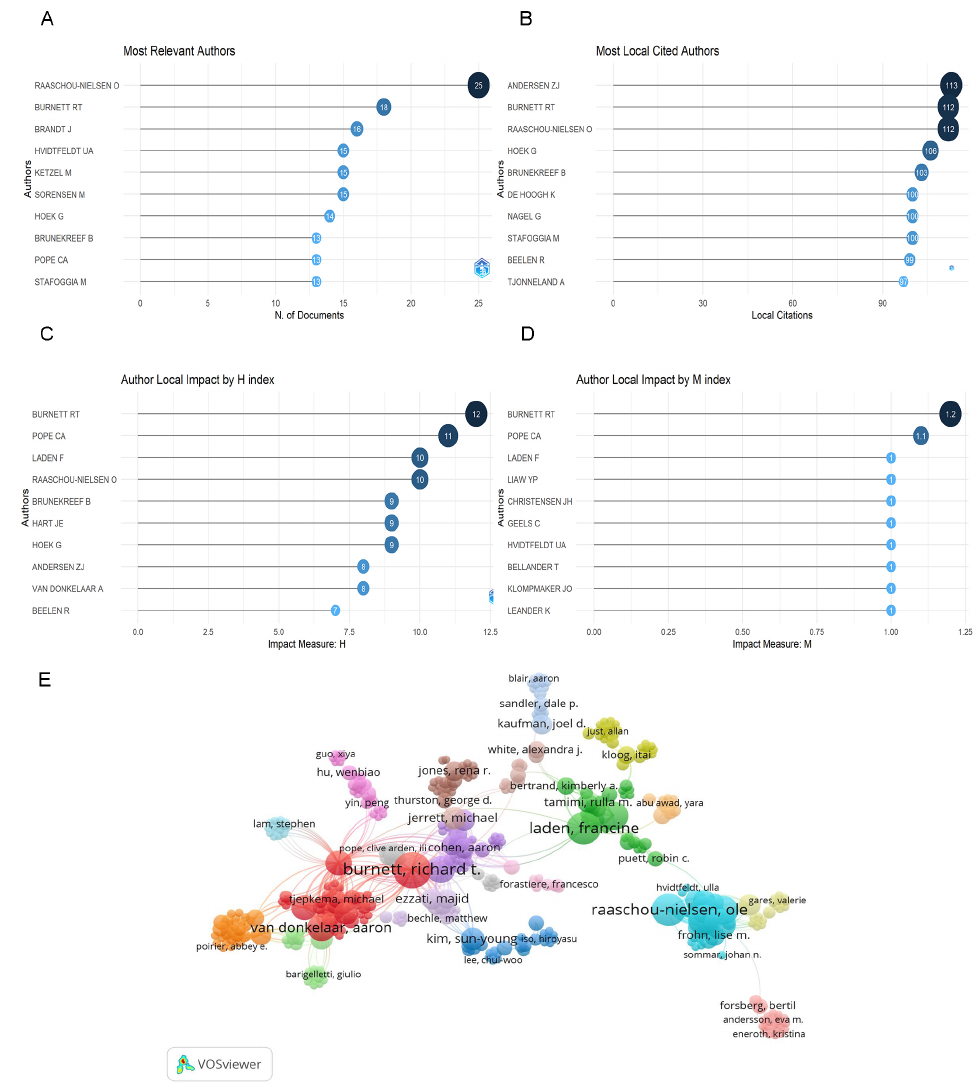
Figure 3. Analysis of authors. ( A ) Number of publications from different authors. ( B ) Total citations Figure 3. in the research filed from different authors. ( C ) H-index of publications from different authors. ( D ) M-index of publications from different authors. The above are listed in the top ten. ( E ) Network visualization between the most connected